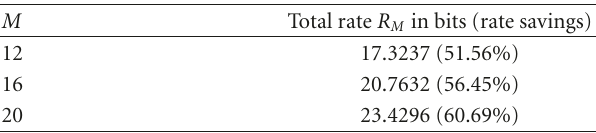
Table 2: Total rate R M in bits (rate savings) achieved by distributed encoding algorithm (global merging technique). The rate savings is averaged over 20 di ff erent node configurations, where each node uses LSQ with R i = 3